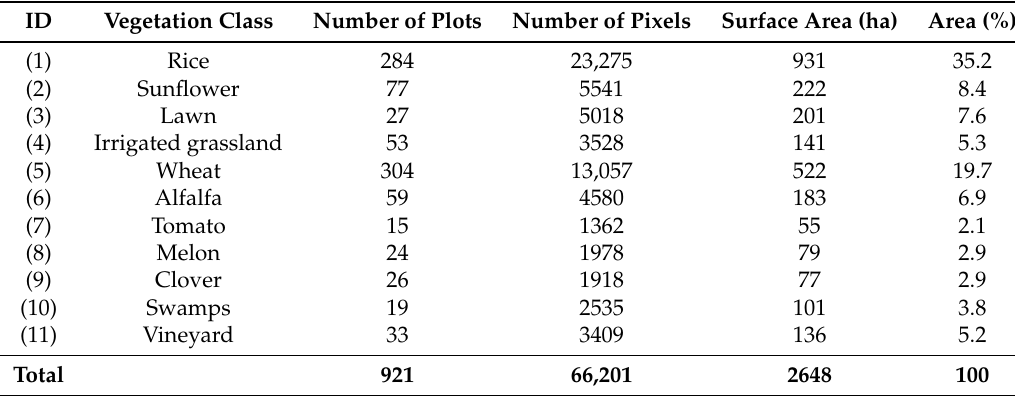
Table 1. The distribution of the number of pixel and plots per class.